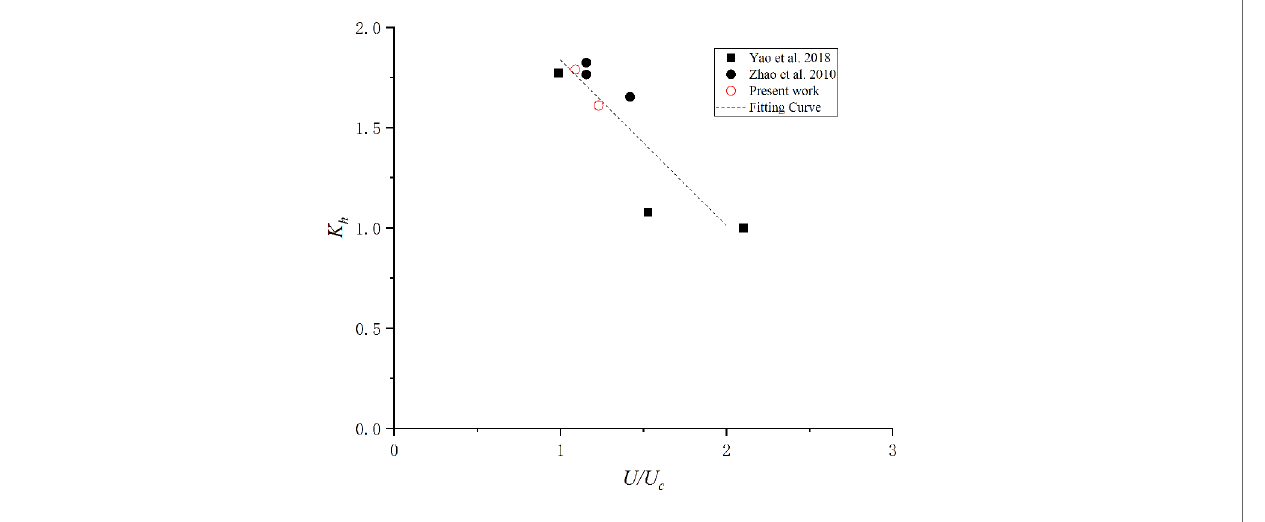
FIGURE 10 | K h values of experimental data; dashed lines, fi tting curve by Eq.